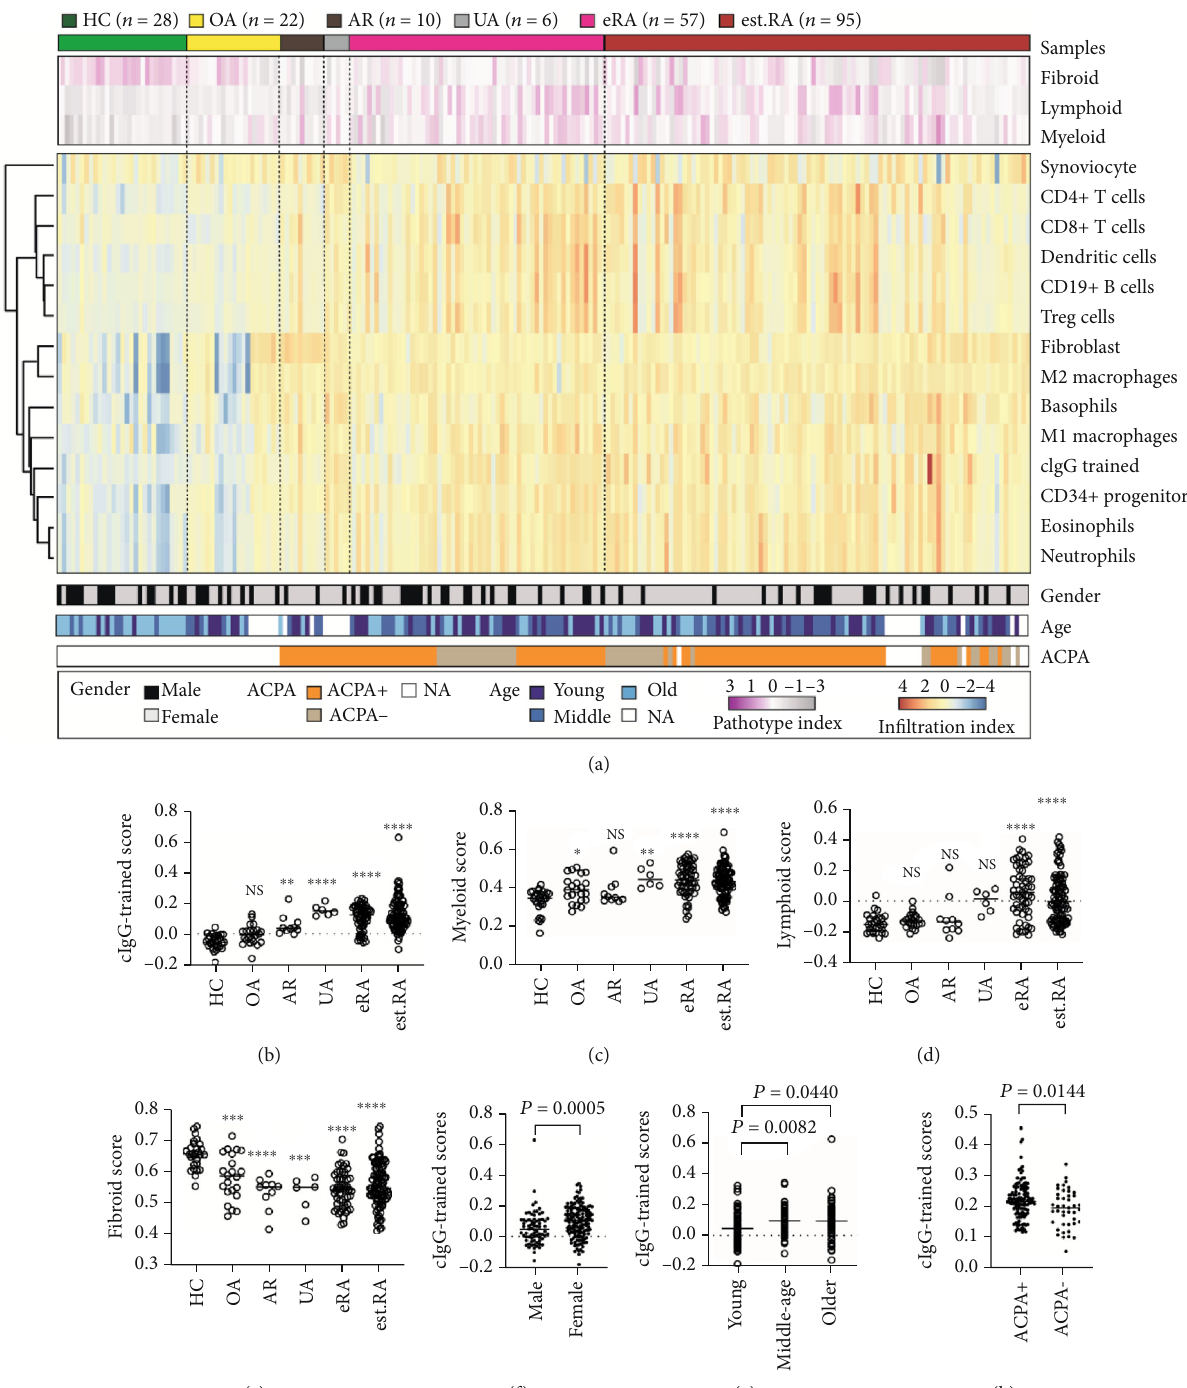
Figure 5: cIgG-trained signatures enriched in synovial biopsies. (a) Heatmap showing hierarchical clustering according to disease status, pathotype, cell-speci fi c gene score, and clinical information. The synovial samples were from healthy donors (HC, n = 28 ) and from patients with osteoarthritis (OA, n = 22 ), arthralgia (AR, n = 10 ), undi ff erentiated arthritis (UA, n = 6 ), early RA (eRA, n = 57 ), and established RA (est.RA, n = 95 ). (b – e) Enriched scores of cIgG-trained monocytes and three pathotypes among the groups. Comparison of cIgG-trained scores in groups according to (f) sex, (g) age, and (h) ACPA status is shown. Each dot represents one donor. NS: no statistical signi fi cance; ∗ P < 0 : 05 , ∗∗ P < 0 : 01 , and ∗∗∗ P < 0 : 001 . The Kruskal – Wallis test, followed by post hoc testing by Dunn ’ s multiple comparison test, was used for comparing > 2 groups. The Mann – Whitney U test was used for comparing two